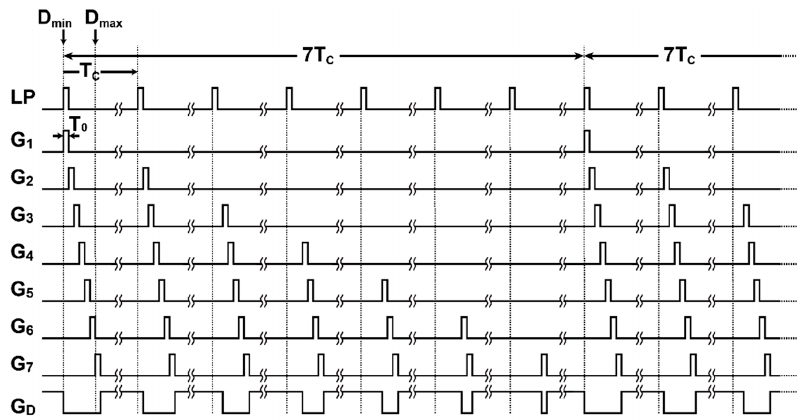
Figure 3. Depth-adaptive time-gating-number assignment for efficient SP-TOF measurement.